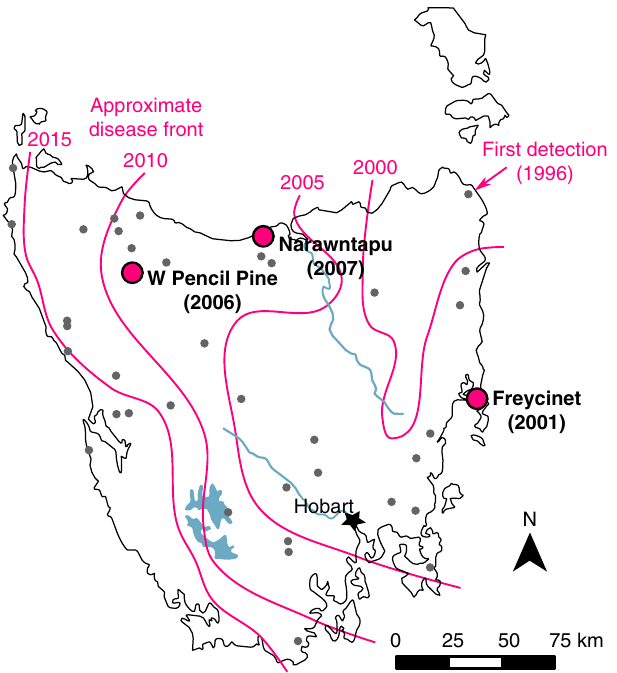
Figure 1 | Sample collection sites in Tasmania. The three focal populations are labelled and marked with large magenta circles; smaller grey circles mark additional sampling sites, which were sampled across the entire geographic range to capture a species-wide representation of genetic diversity. The magenta lines indicate the approximate location of the disease front 6,7 in 2000, 2005, 2010 and